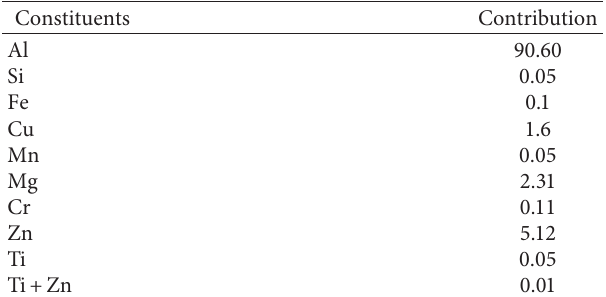
Table 1: Chemical constitutions of Al7075 alloy.